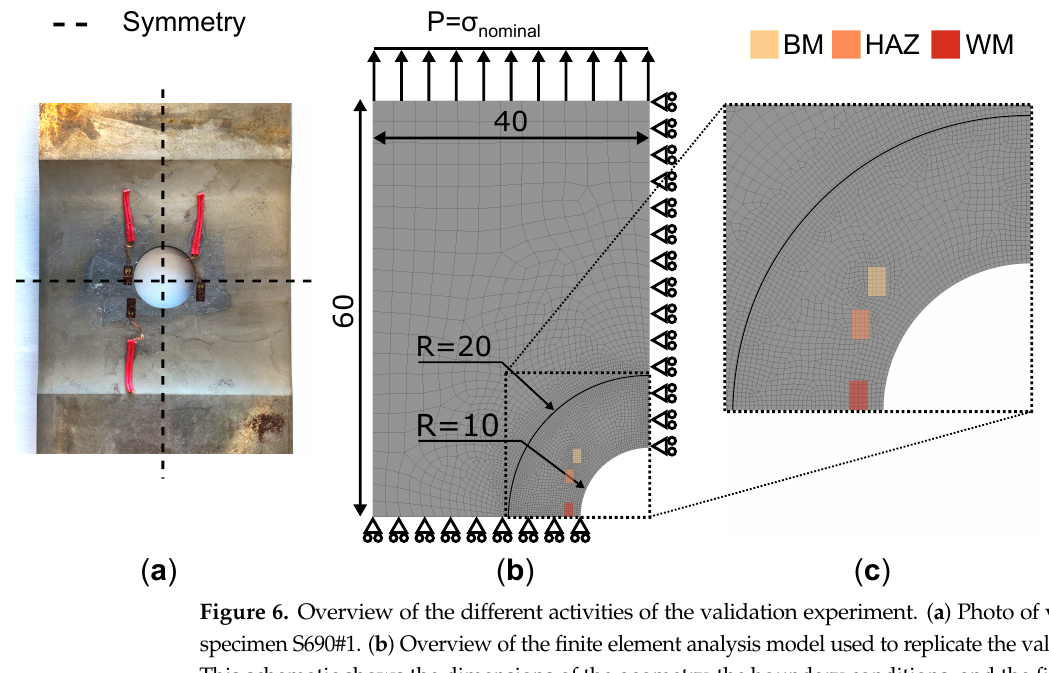
Figure 6. Overview of the different activities of the validation experiment. ( a ) Photo of validation test specimen S690#1. ( b ) Overview of the finite element analysis model used to replicate the validation results. This schematic shows the dimensions of the geometry, the boundary conditions, and the final mesh. The geometry is reduced to a two-dimensional geometry using a plane strain assumption. ( c ) Mesh refinement around the circular notch. The positions of the strain gauges are highlighted in